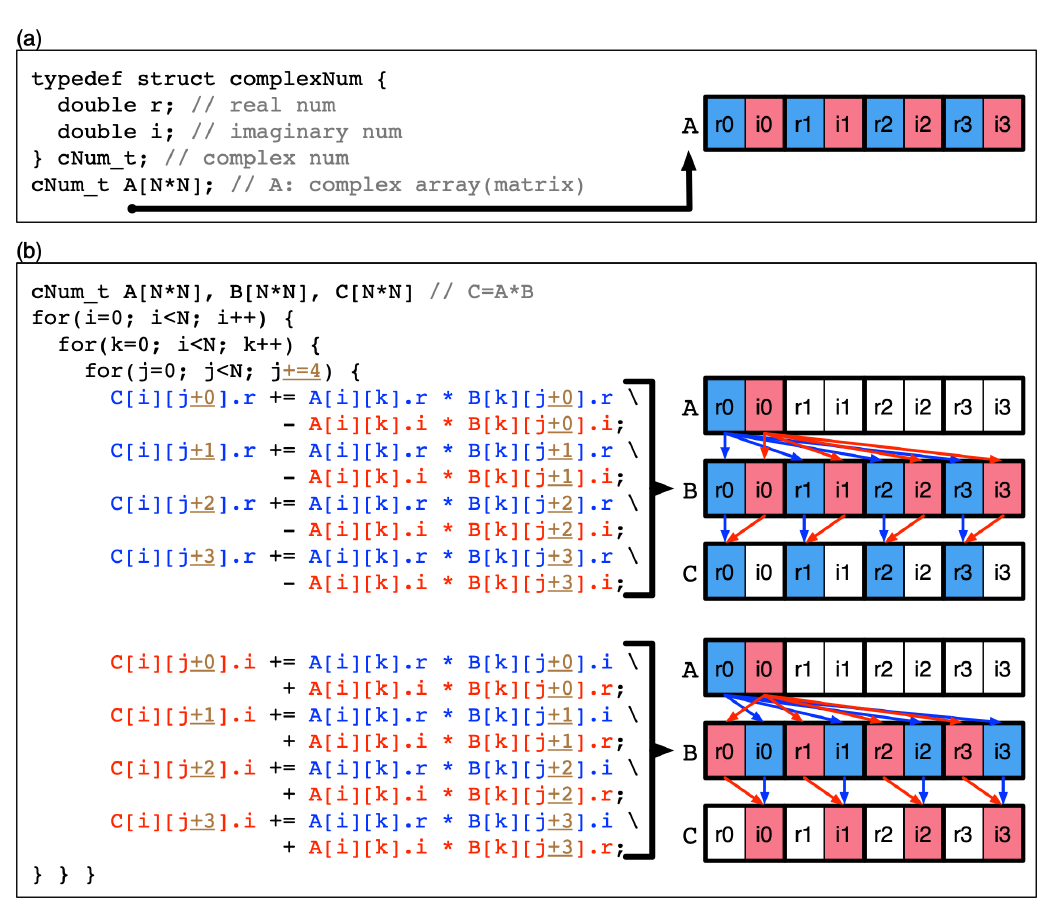
Figure 3. Matrix multiplication with single instruction multiple data (SIMD) (or single instruction multiple threads (SIMT)) where two complex matrices are constructed with arrays of structures. ( a ) A real and an imaginary number are grouped into a structure to describe a single complex number, and arrays of structures are used to represent matrices. ( b ) During multiplication of two complex matrices, elements are accessed with a stride = 2, so the multiplication process cannot fully exploit the benefit of SIMD (or